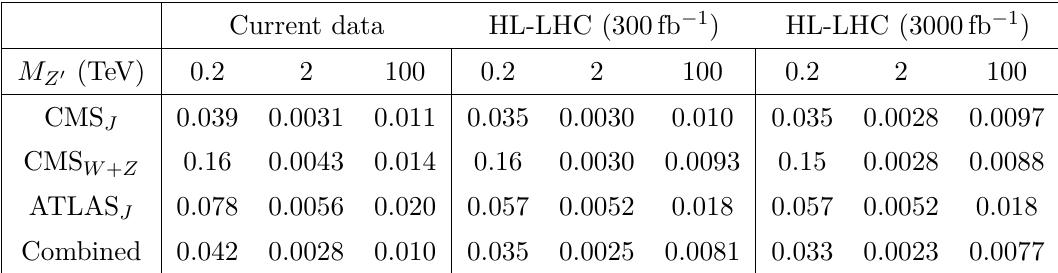
Table 2. Summary of current and projected 95% CLs upper limit on NSIs in a simplified Z 0 model with Z 0 mass of 0.2, 2, and 100 TeV respectively. We assume (cid:15) u = (cid:15) d = (cid:15) and Γ Z 0 /M Z 0 = 0 . 1 , and use the NLO predictions with theoretical